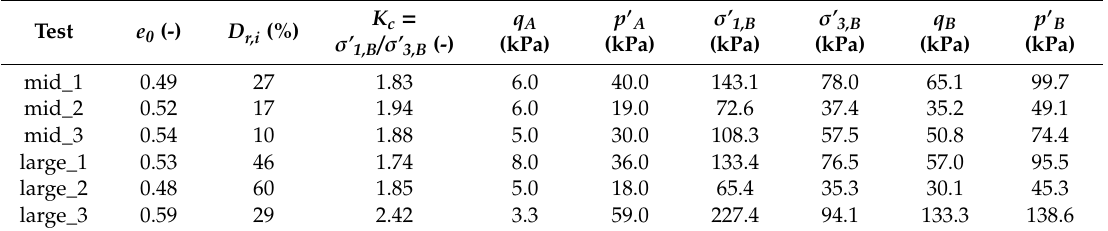
Table 2. Triaxial testing programme on gravelly scree soil: specimen